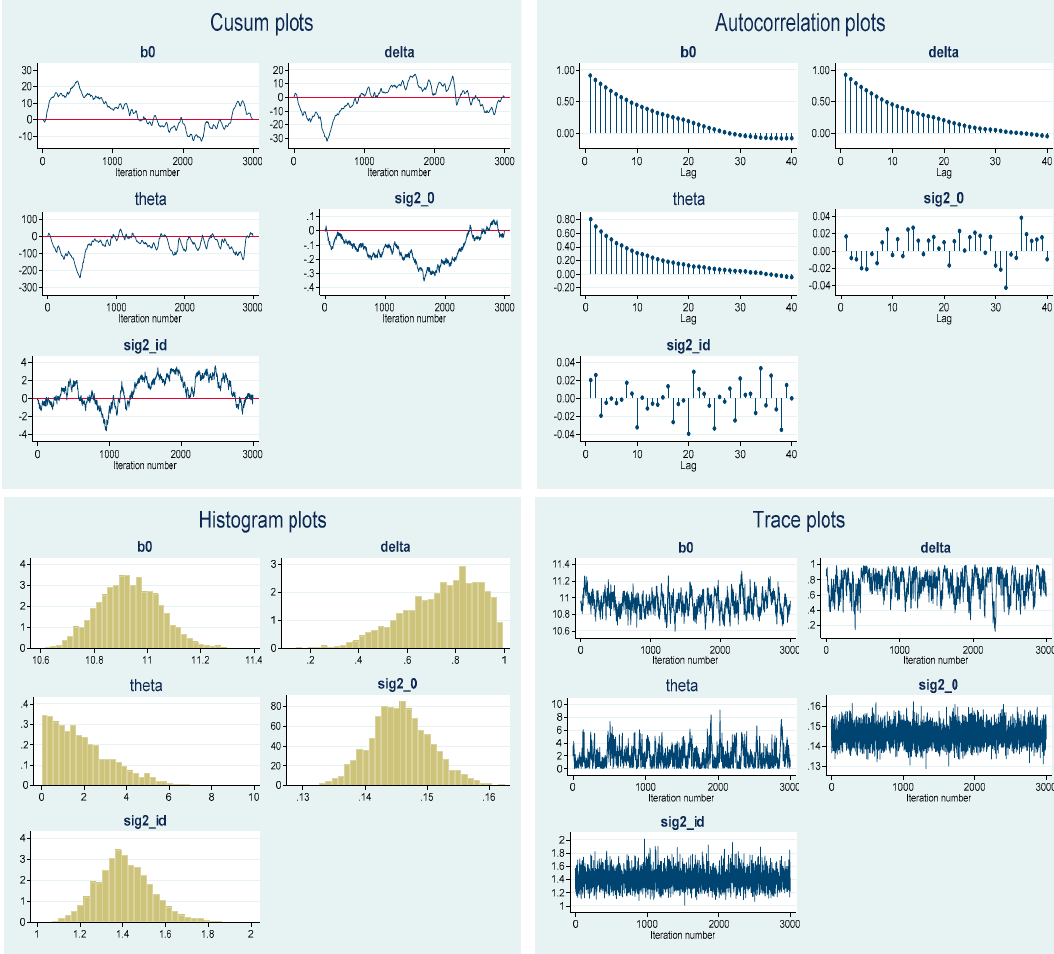
Figure 1. Graphical convergence diagnostics.